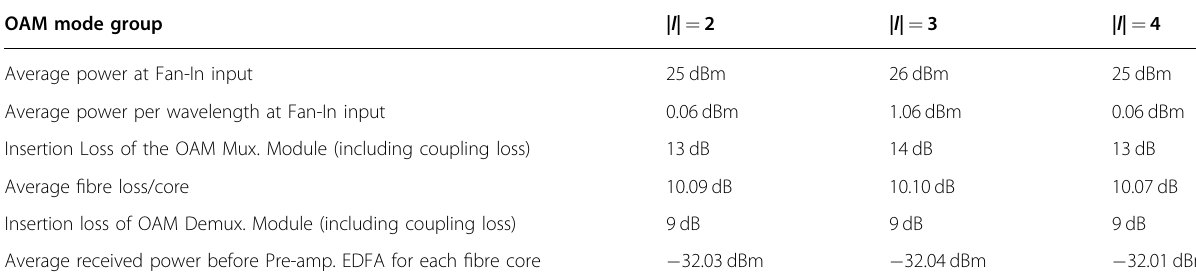
Table 1 Optical power budget evaluation of the OAM-SDM-WDM experiment systems. OAM mode